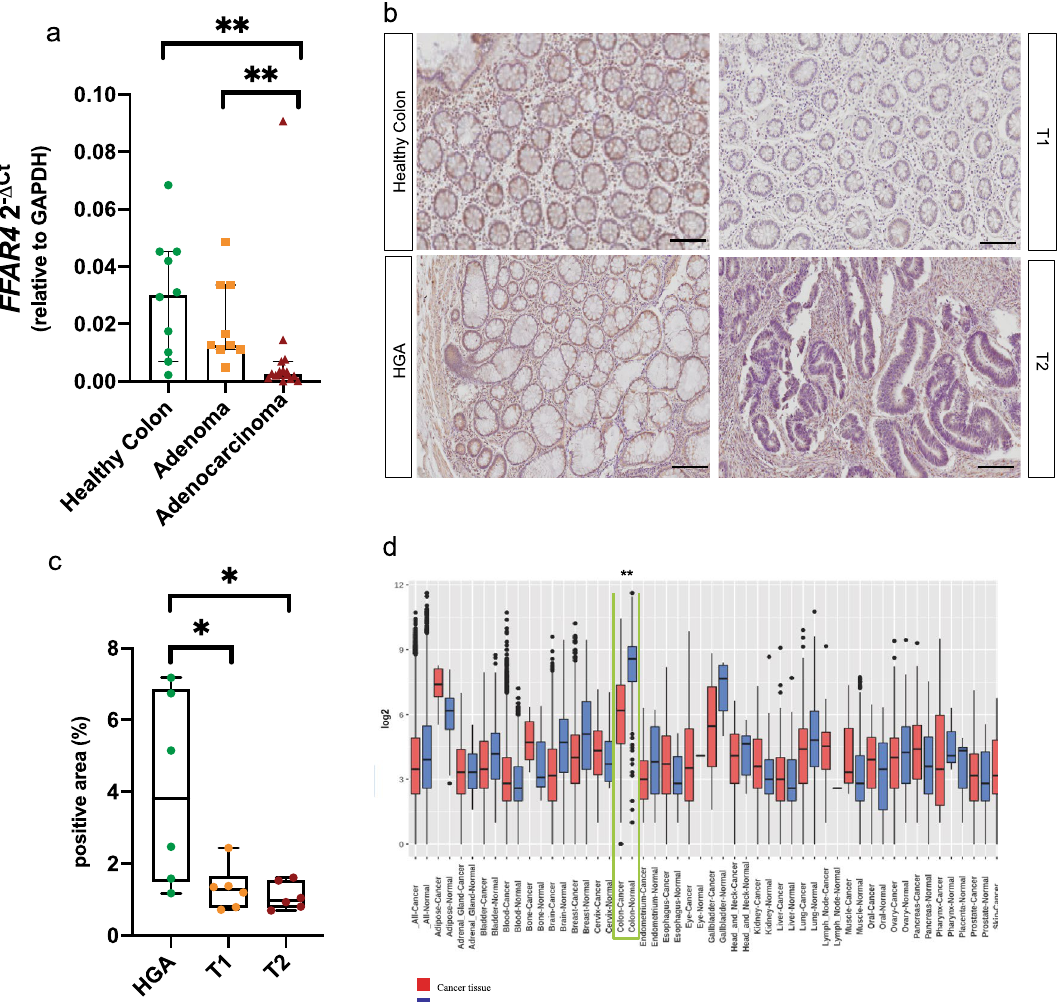
Figure 4. Loss of epithelial GPR120 correlates with CRC development ( a ) The expression levels of FFAR4 gene were quantified by qRT-PCR in healthy colon (n = 9), adenomas (n = 9) and adenocarcinoma (n = 17) from human samples. ( b ) Representative immunostaining for GPR120 in human samples of Normal mucosa (n = 6), High-Grade Adenomas (HGA) (n = 6), T1 (n = 6) and T2 (n = 6) tumors, ( c ) and relative quantification of positive area. Values are expressed as median percentage of positive over total area ± 95% CI. Magnification: 20X . Scale bar: 50 μm. ( d ) Gene expression of FFAR4 in the indicated tissues annotated in the GENT2 database, expressed as Log2 and plotted according to tissue type. Values are expressed as median (horizontal line) ± IQR (interquartile range, boxes), dots represent outliers. Green box highlights FFAR4 expression in CRC (n = 4047) and healthy (n = 398) colon tissue. *p value < 0.05; **p.value < 0.001 by Mann Whitney test (a-c) and Student t test ( d